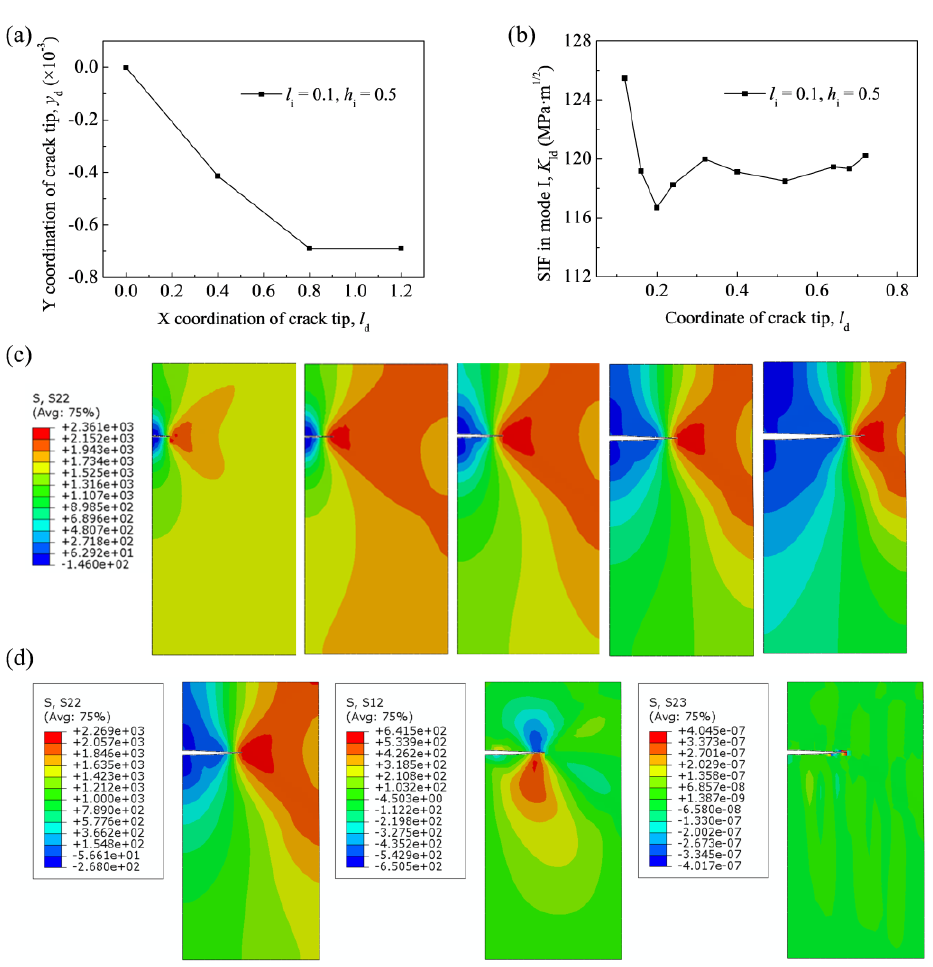
Figure 5. ( a ) Crack propagation path; ( b ) K Id in the propagation process for an in-plane model when the initial crack length is 0.1 and the crack location is 0.5; ( c ) S 22 stress contours in the crack propa- gation process; ( d ) Comparison of stress contours in three orientations when the crack propagates to 0.4.